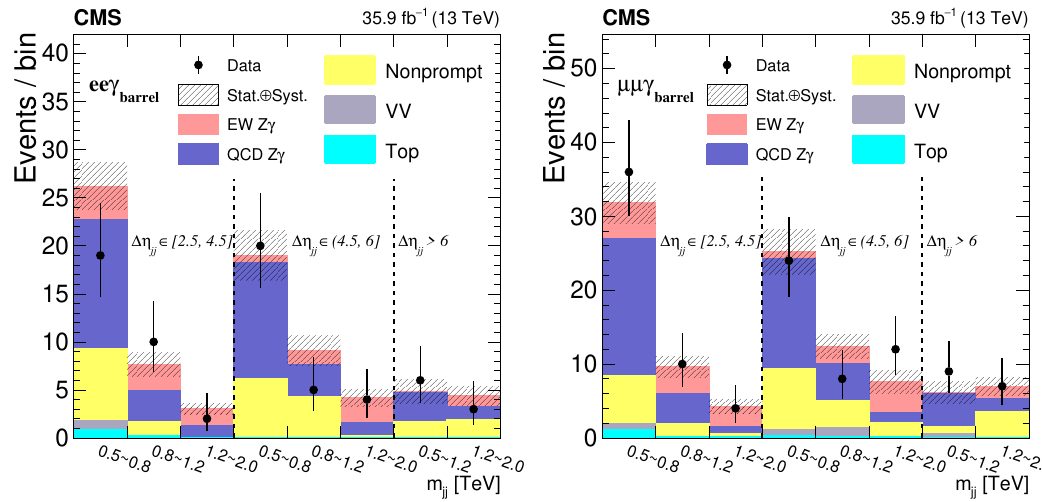
Figure 4 . The post-(cid:12)t 2D distributions of the dielectron (left) and dimuon (right) + (cid:13) categories as a function of m in bins of (cid:1) (cid:17) . The horizontal axis is split into bins of (cid:1) (cid:17) jj jj 4.5], (4.5, 6.0], and > 6 : 0. The data are compared to the signal and background predictions in the signal region. The black points with error bars represent the data and statistical uncertainties of data, the hatched bands represent the full uncertainties of the predictions.